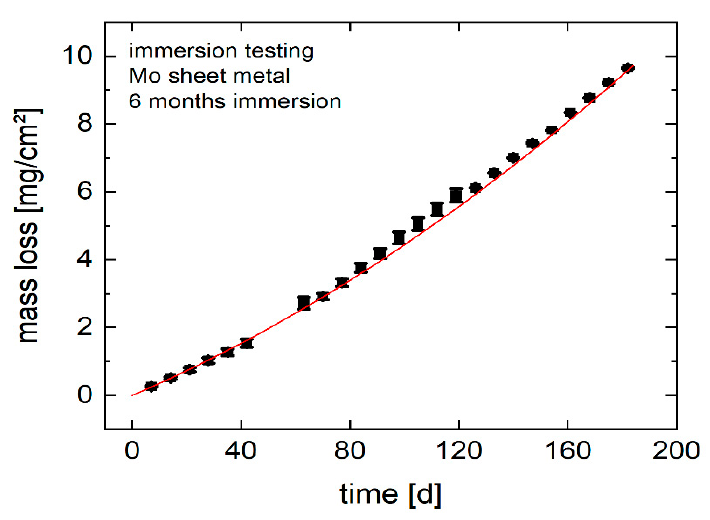
Figure 7. Mass loss of molybdenum sheet metal over 6 months of immersion, derived from ICP-OES measurements.